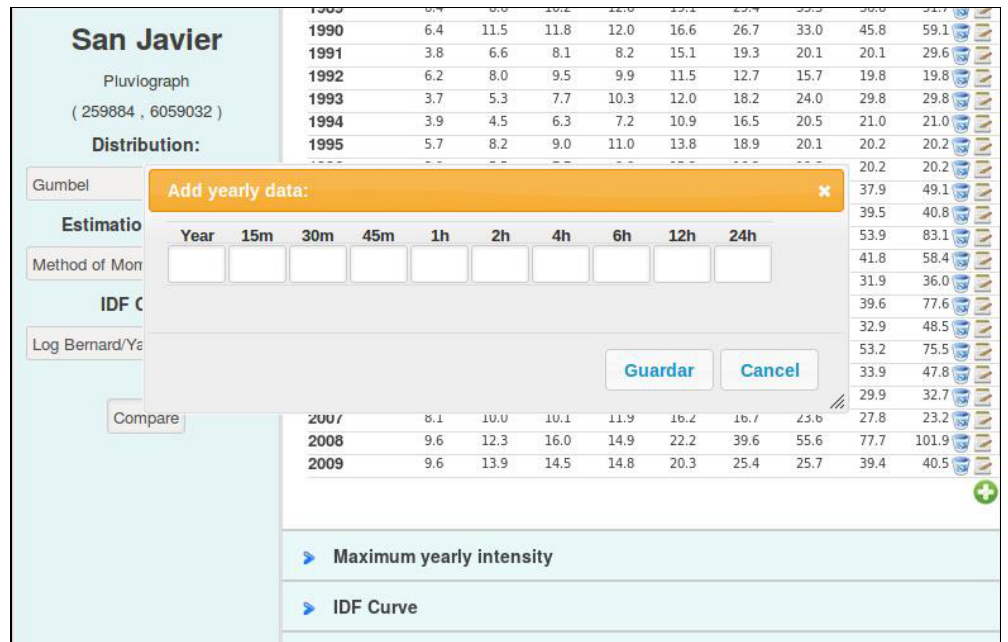
Figure 8. Tabular form of precipitation accumulation data from a pluviograph gauge (San Javier) included in WEBSE IDF . New precipitation accumulation data for different durations can be inserted, as shown.